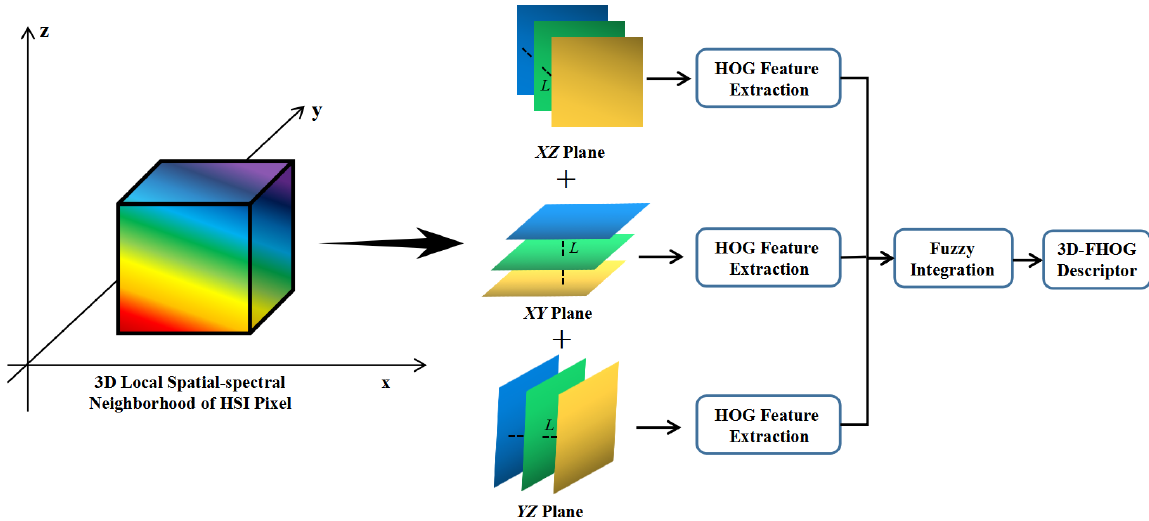
Figure 2. The schematic of 3D-FHOG feature extraction.